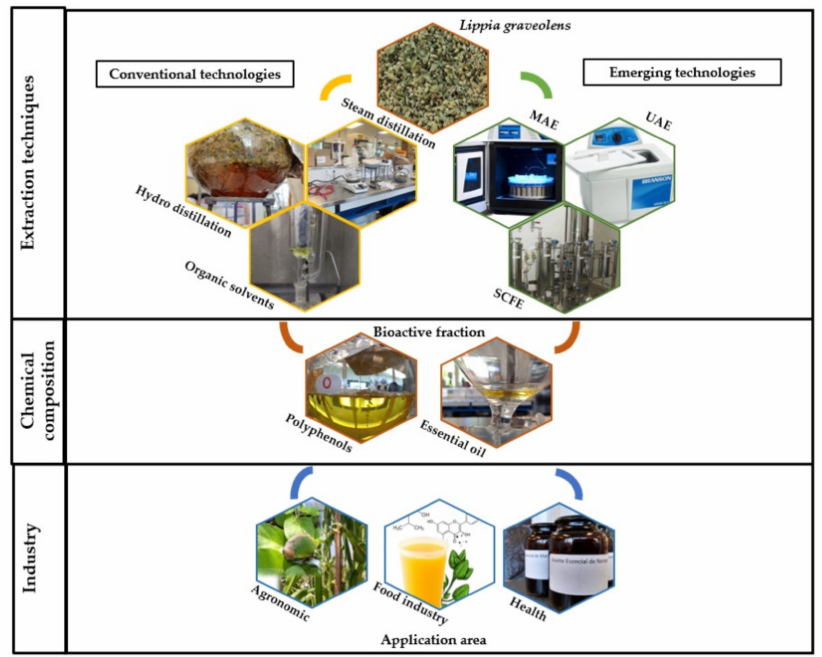
Figure 3. Extraction technologies, products, and application areas of Mexican oregano ( L. graveolens ). [MAE: Microwave-assisted extraction; UAE: Ultrasound-assisted extraction; SCFE: Supercritical fluid